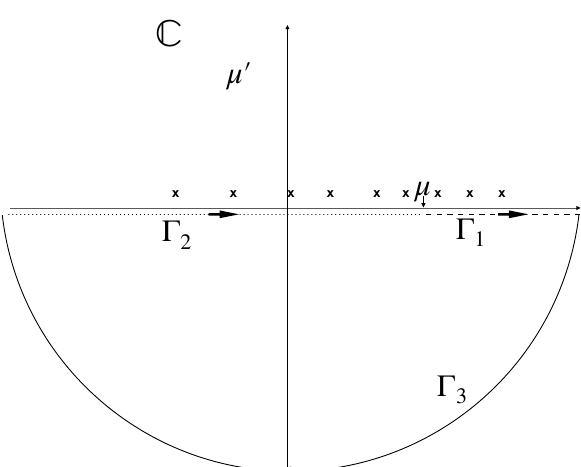
= ( −∞ , µ ) 2 is used to close the contour 3